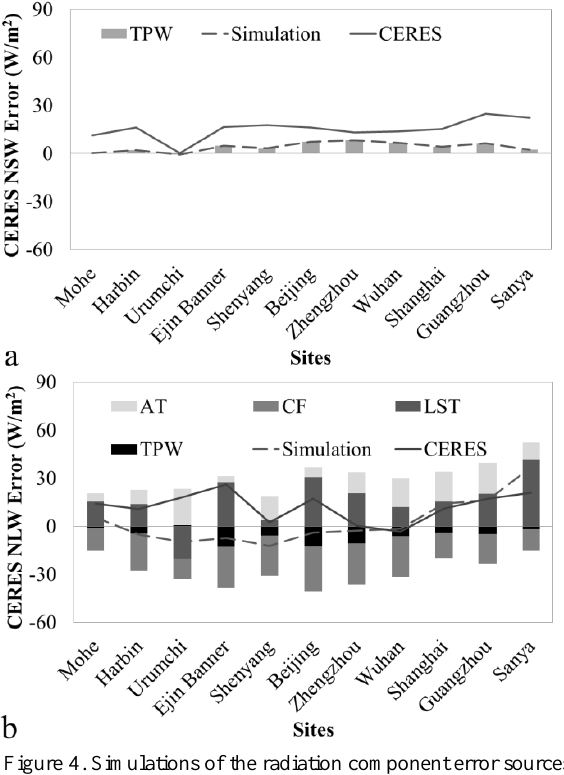
Figure 4. Simulations of the radiation component error sources at the 11 level-1 sites, including the (a) NSW situation, (b) NLW situation, with the simulated and real error of